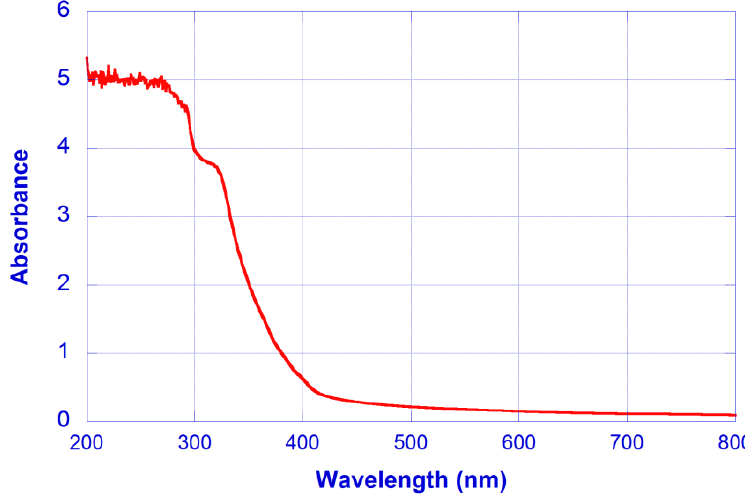
Figure 5. Absorbance spectrum of the CN-hydrogel.